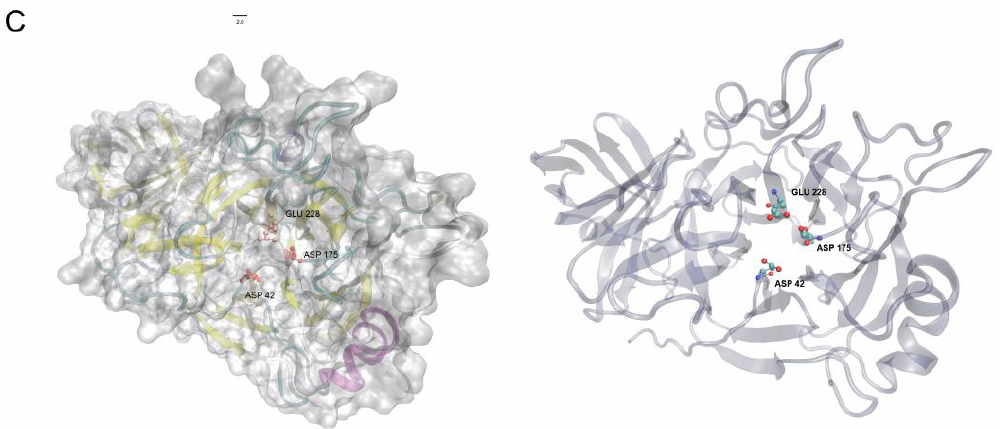
Figure 3. H1AD43 protein property analysis. ( A ) Evolutionary tree analysis of the GH43 family members from different microbial sources; ( B ) H1AD43 hydrophilicity and hydrophobicity analysis; ( C ) H1AD43 structure modeling.